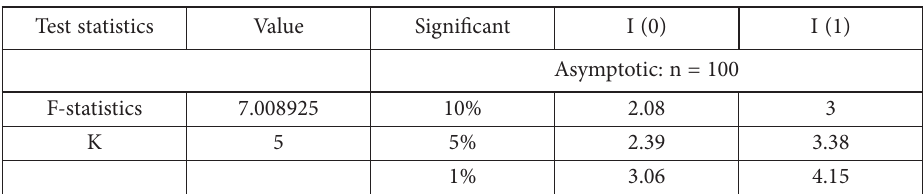
Table 9. The bounds test